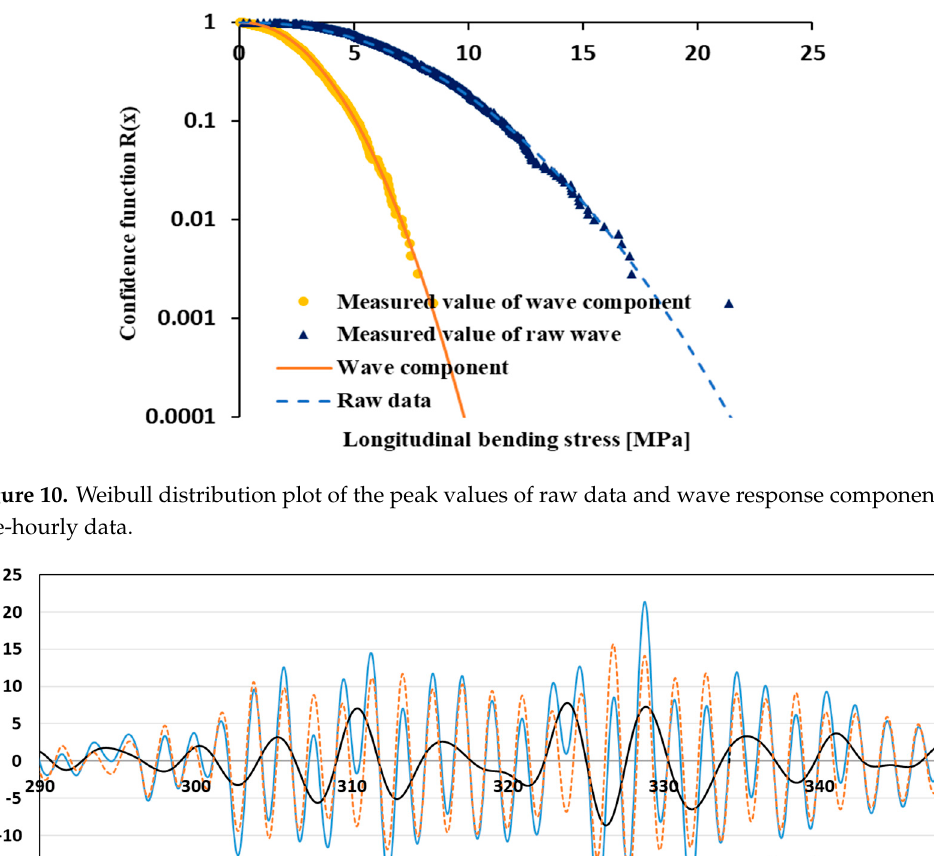
Figure 12. Time-series stress data during 830–890 s of the vertical longitudinal bending component. These phenomena were observed several times within this one-hour short-term period. The number of occurrences of the whipping response was evaluated through visual observation of the time-series data, and it was 68, where 11 of these occurrences were the superposition phenomena and 13 of these occurrences were the phenomena of cancellation. These percentages were approximately 13% and 19%, respectively, showing quite frequent chances of such superposition or cancellation of whipping to the existing free decay vibration. It was confirmed that this whipping superposition phenomenon also occurred in other short- term sea conditions, and the whipping factor in these cases was relatively large. 6. Conclusions In this study, we analyzed the measured hull girder longitudinal stresses onboard an 8600 TEU container ship to reveal the whipping behavior. We decomposed the longitudinal stresses at the four corners of the midship into the vertical bending, horizontal bending, torsional, and axial force components. Then, the whipping factors were calculated for each one-hour sea state with regard to the vertical bending, torsional, and horizontal bending components. The following findings were drawn from this study: 1.